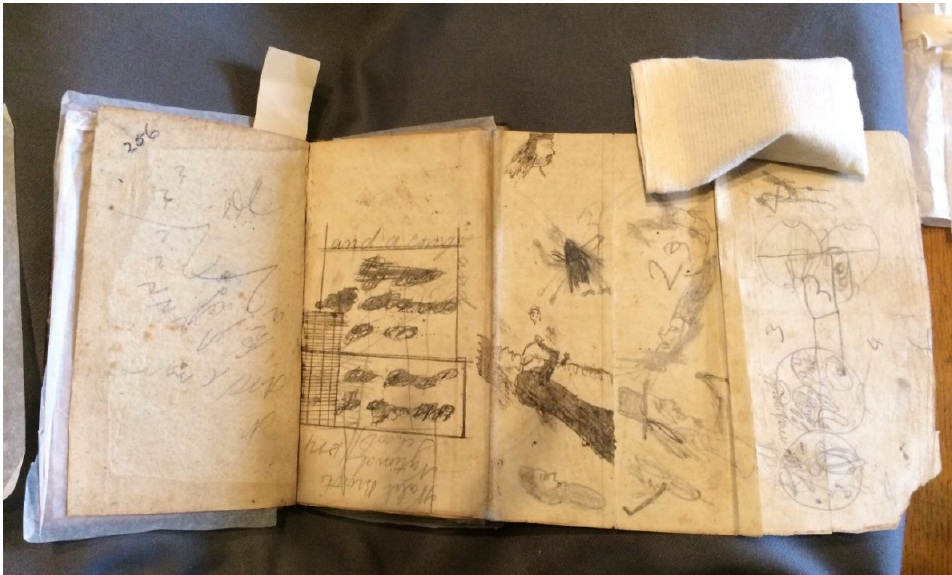
Figure 8. Back of a foldout map of Europe from the Brontë copy of Goldsmith’s Geography . The texts’ regulatory authority ended at the printed line—sometimes not even then, as Charlotte could be known to correct her grammar book and Emily added place names from her invented islands Gondal and Gaaldine (see Figure 9):